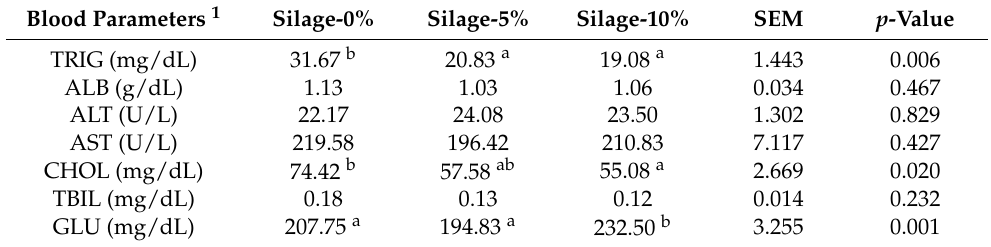
Table 5. Effect of silage supplementation on broiler blood biochemical parameters.